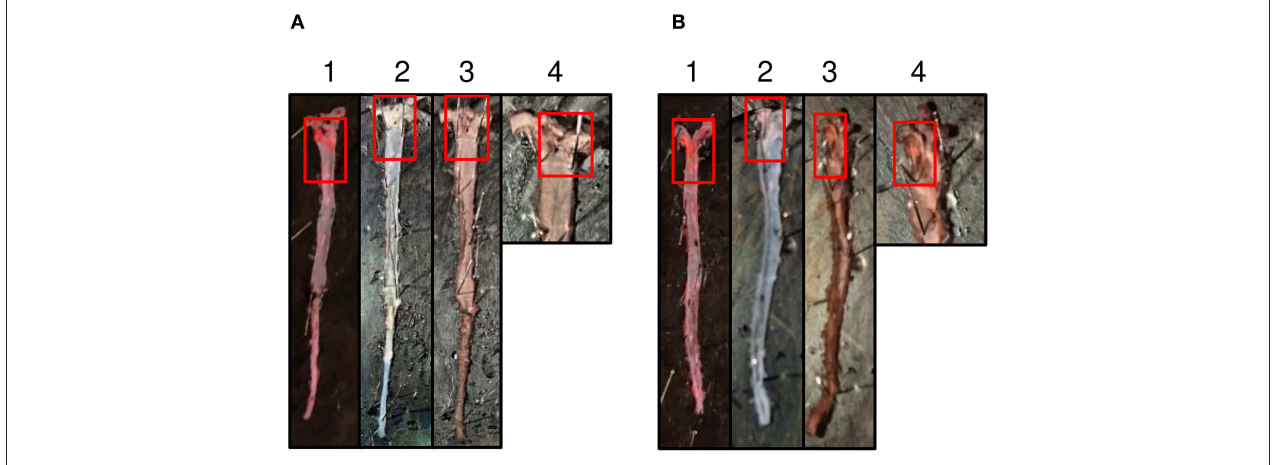
FIGURE 5 | Immunostaining of mutant CRP in the aorta. (A) A representative aorta from untreated mice stained for mutant CRP. (B) A representative aorta from mice treated with mutant CRP for 7 weeks, stained for CRP. 1–4 represent an aorta through different stages of staining. (1) Sudan IV-stained aorta. Red colored areas are the lesions. (2) Aorta post-dehydration to remove Sudan IV. White colored areas are the lesion areas. (3) Anti-human CRP antibody-stained aorta. Brown colored areas reflect the presence of mutant CRP in the lesions. (4) Magnified aortic arch area of the anti-human CRP antibody-stained aorta. Red boxes show the lesion areas.